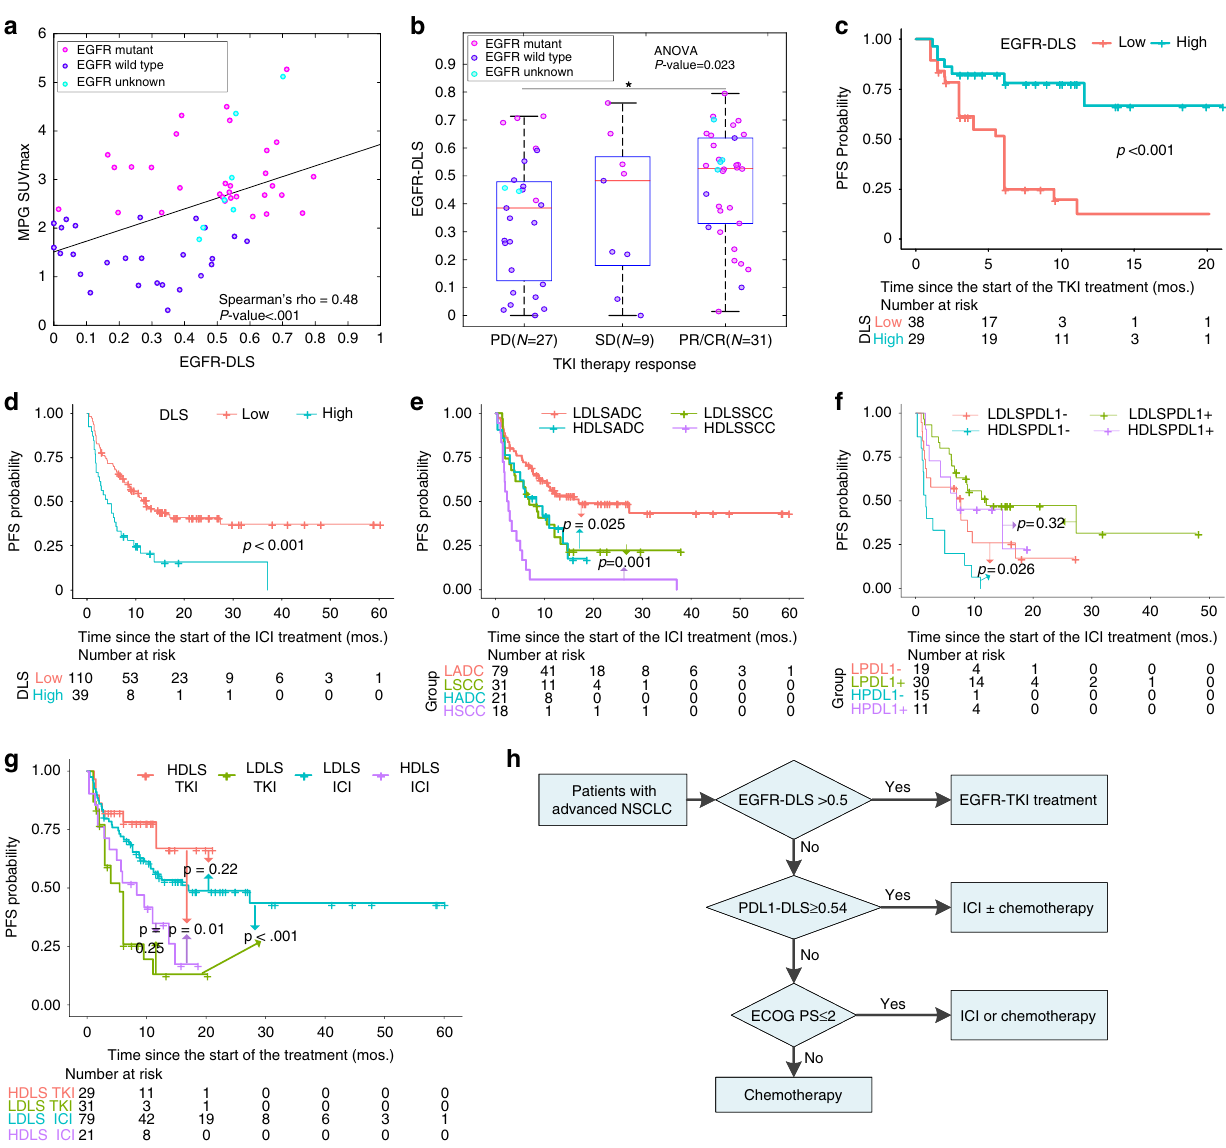
ADC and SCC subgroups (Fig. 4e and Supplementary Table 7). The results of the strati fi ed analysis based on PD-L1 status (Fig. 4f and Supplementary Table 8) showed that high EGFR-DLS was still signi fi cantly associated with poor outcomes among patients with negative PD-L1 status, i.e., patients with low EGFR-DLS and positive PD-L1 status had the longest PFS, and this was observed